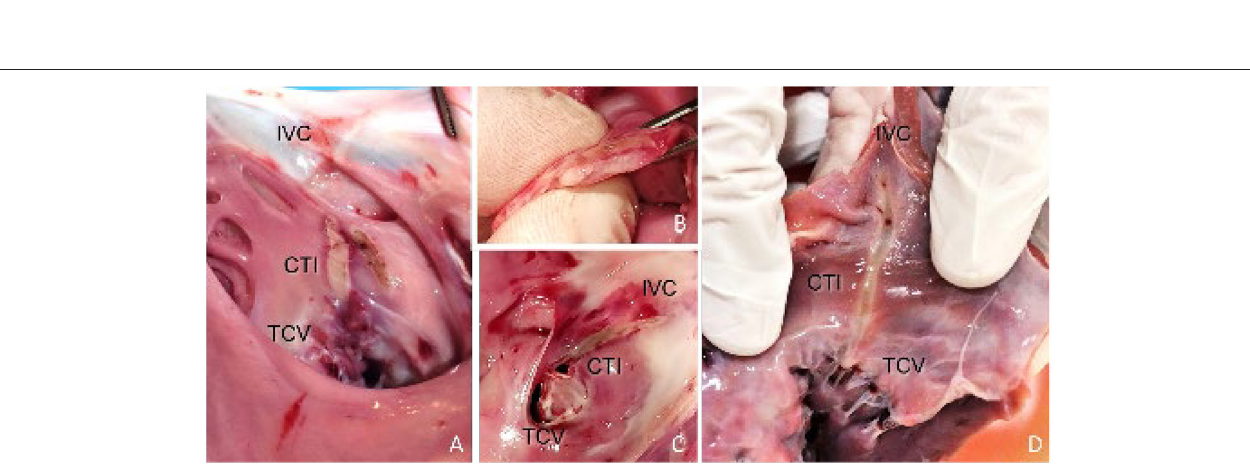
FIGURE 3 | Endocardial view of the RA specimens displaying the pale linear lesion. (A) Incomplete CTI ablation, showing the created lesions of 4 power applications at 25W for 60s. One application was set parallel to the rest. (B,C) Full CTI ablation including axial section, confirming transmurality and linearity. The lesion extended from the TCV toward the IVC. (D) Full CTI ablation, requiring only two energy applications of 25 W/60s to complete the lesion.